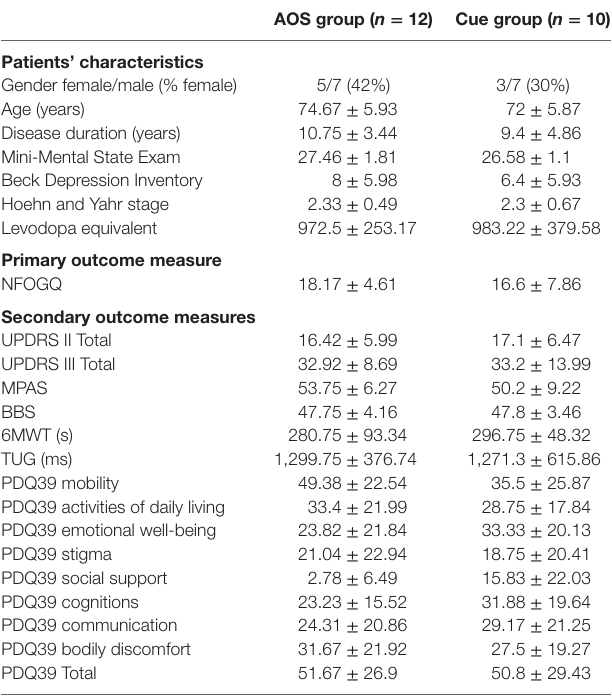
TablE 1 | Demographic and clinical characteristics of patients with Parkinson’s disease at baseline.